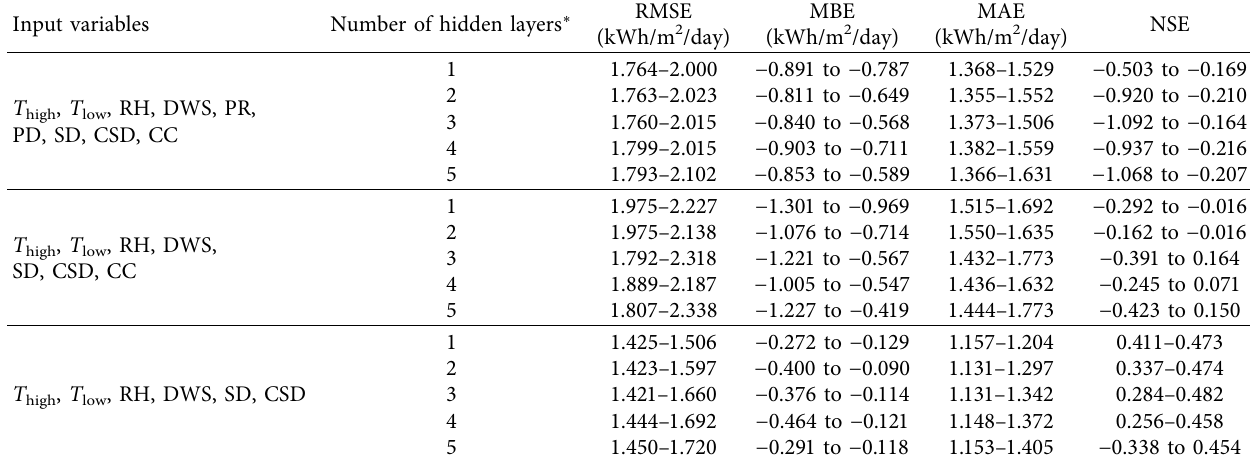
Table 5: Accuracies of predicted value ranges according to the input variables, NHN, and